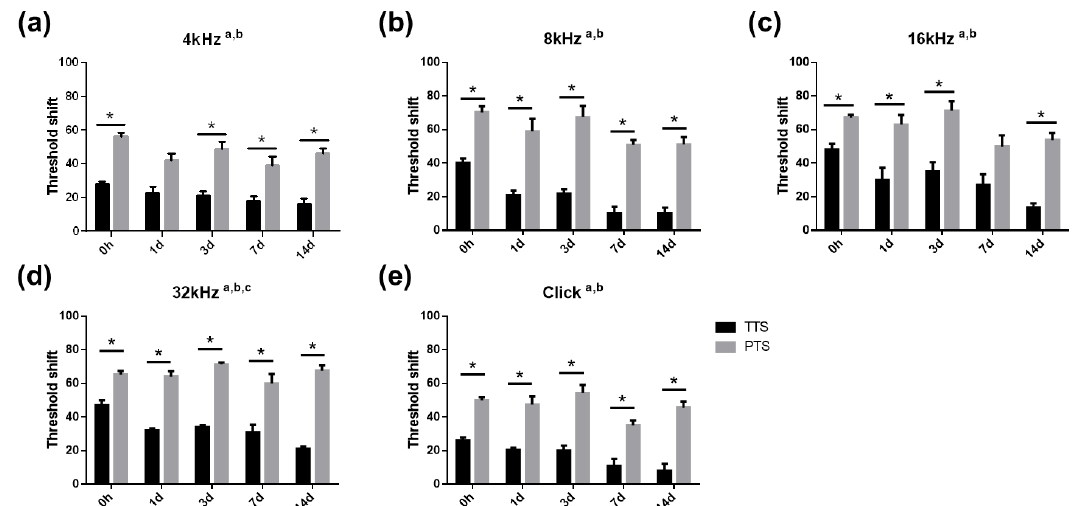
Figure 1. Auditory brainstem response (ABR) threshold shifts after noise exposure. ABR thresholds were measured at the following six time points: prior to (pre), immediately after (0 h), 1 d, 3 d, 7 d, and 14 d after noise exposure and graphed for ABR threshold shifts. Permanent hearing threshold shift (PTS) group showed significantly increased ABR threshold shift as compared with transient hearing threshold shift (TTS) animals at all frequencies and click stimuli at all-time points ( a – e ). TTS, transient threshold shift; PTS, permanent threshold shift; a, main effect of day, p < 0.05; b, main effect of treatment, p < 0.05; and c, interaction, p < 0.05. All graphs represent mean ± S.E.M. Two-way ANOVA, Tukey’s multiple comparisons test. * p < 0.05, n = 25, 0 h; n = 5, 1 d, 3 d, and 7 d; n = 4 and 14 d.